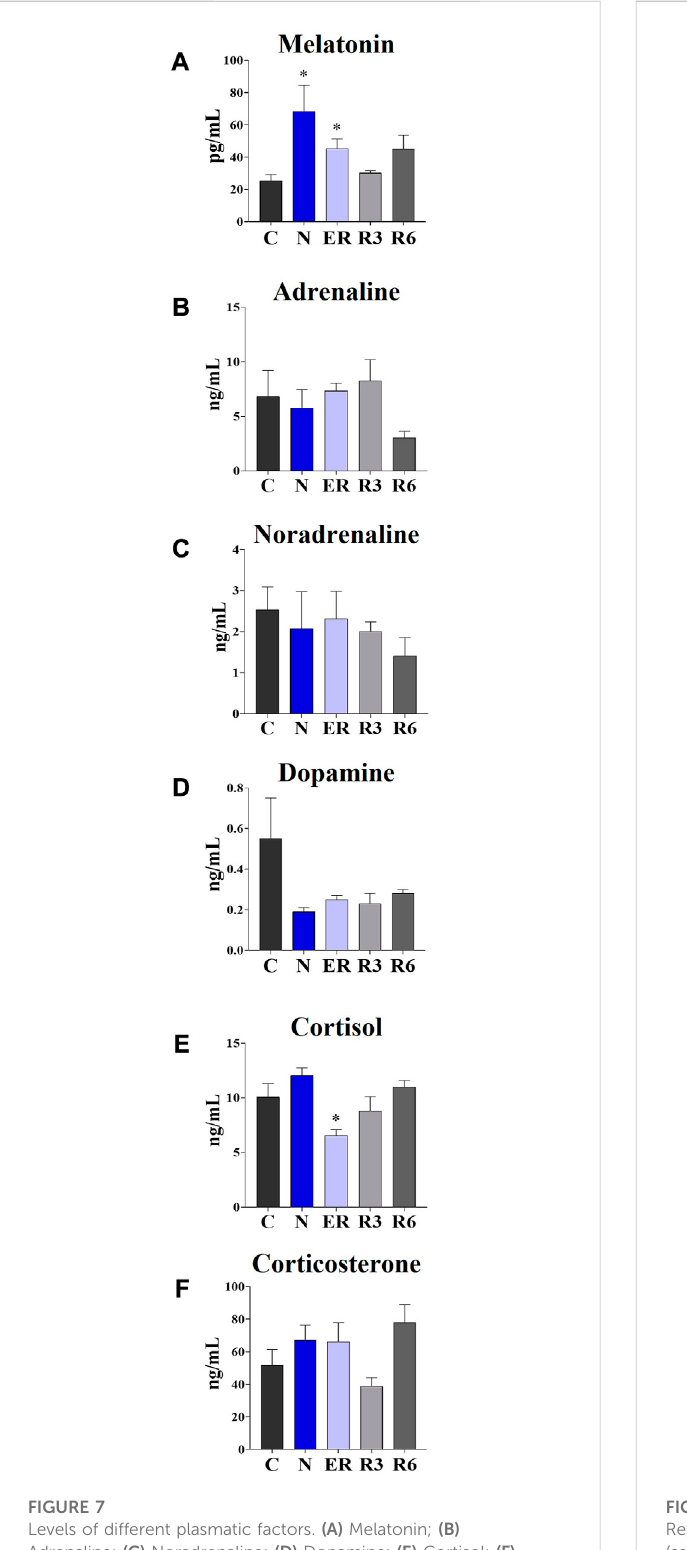
FIGURE 8 Representative pictures showing microglia, stained for Iba1 (secondary antibody conjugated with Alexa-594), in samples from the parietal cortex (P-Cx) randomly taken between Bregma − 2.0 and − 4.0. The inclusions within panels show representative microglial cell at higher magni fi cation. Experimental groups (see Figure 1): C, control; N, samples taken at nadir of hypothermia, during ST; ER, early recovery, samples takenwhenTbreached 35.5 ° C following ST; R3, samples taken 3 h after ER; R6, samples taken 6 h after ER. Calibration bar: 50